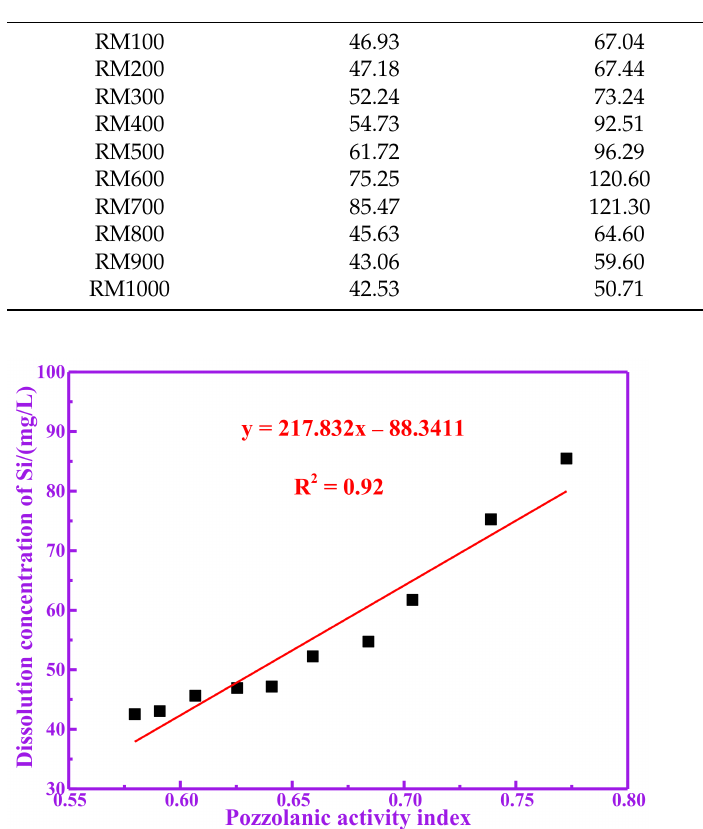
Figure 3. Correlation between dissolution concentration of Si and pozzolanic activity index.